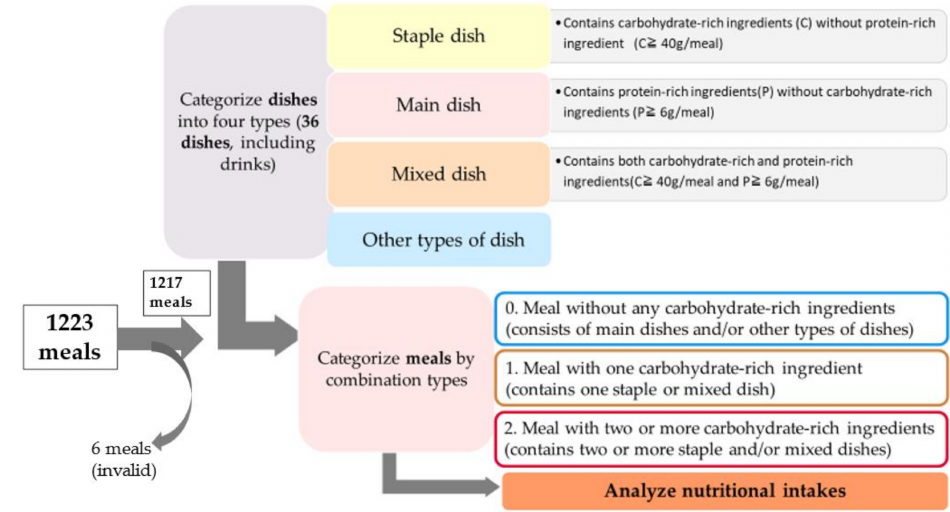
Figure 1. Flowchart of dish combination analysis categorized by meal type.